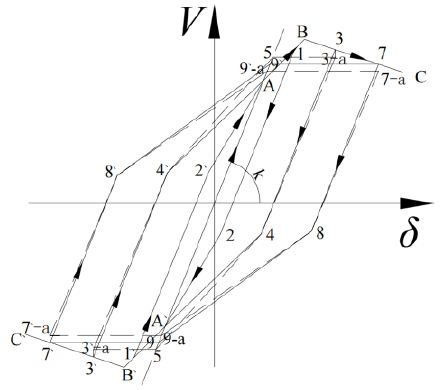
Figure 24. The SRFM for local instability failure.